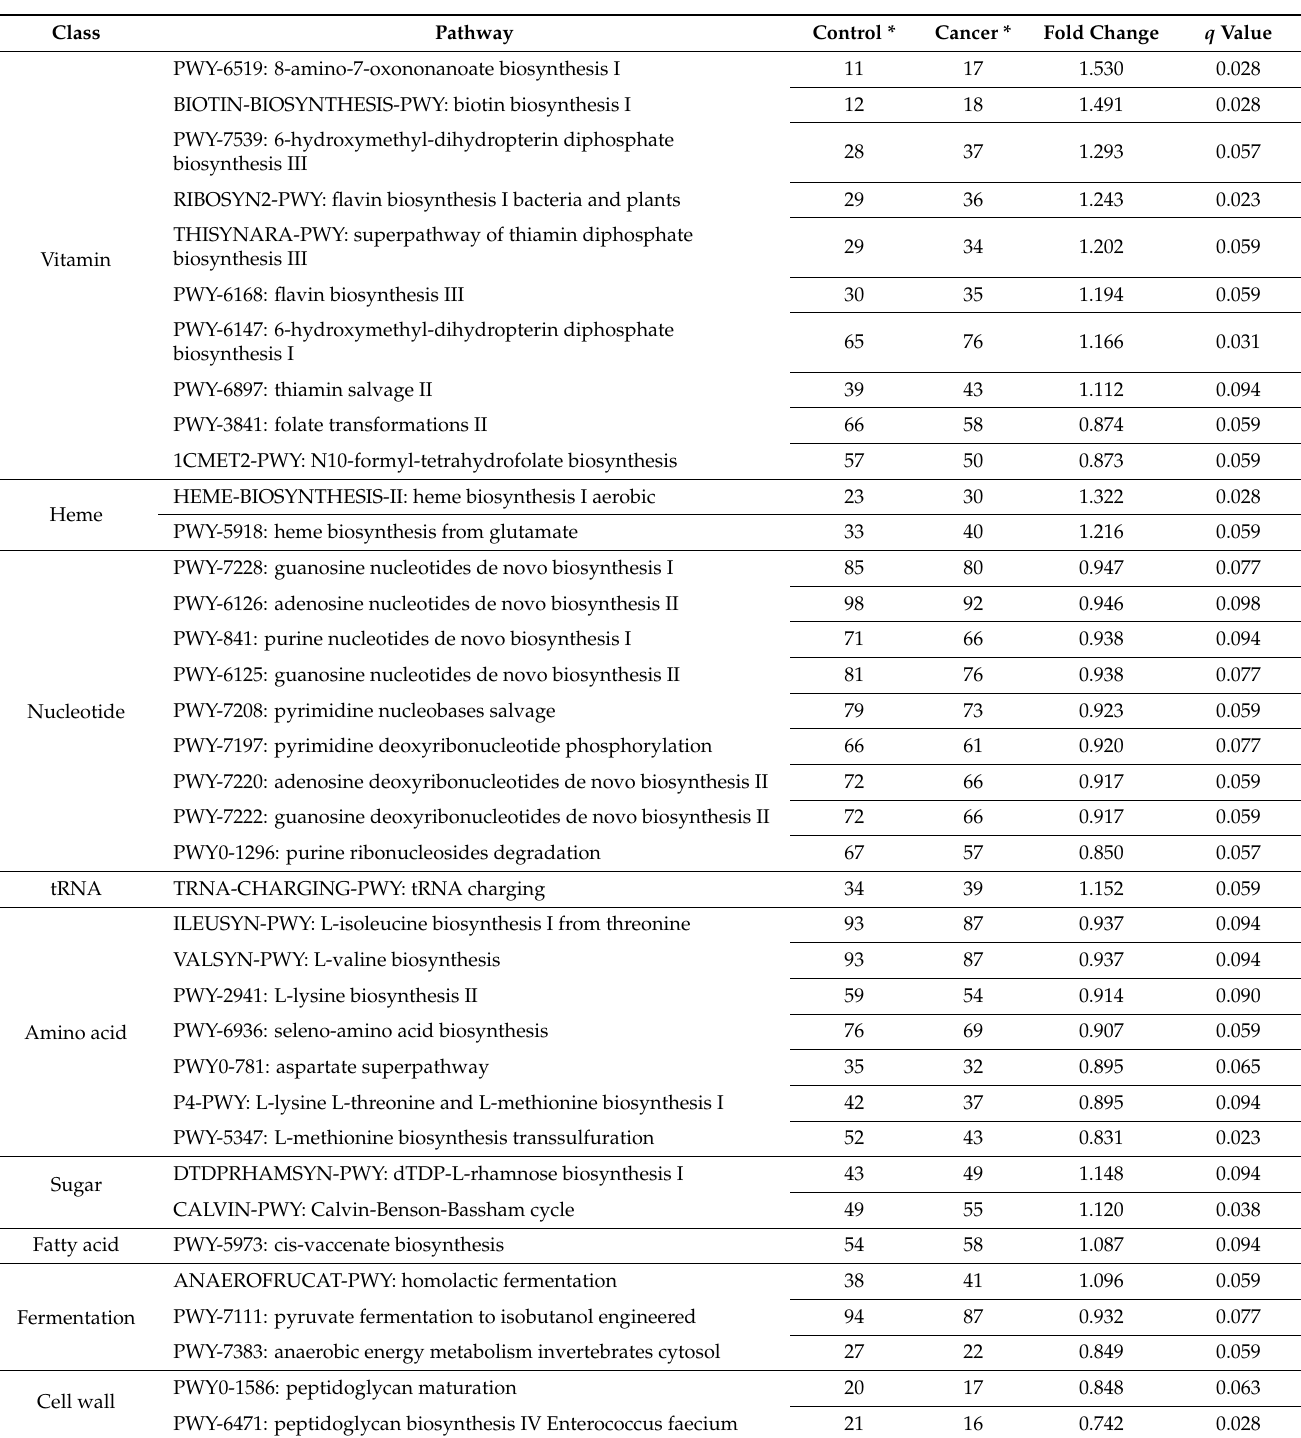
Table 3. Significant changes in 37 microbial pathways in oral microbiome in nonsmoking OC-SCC